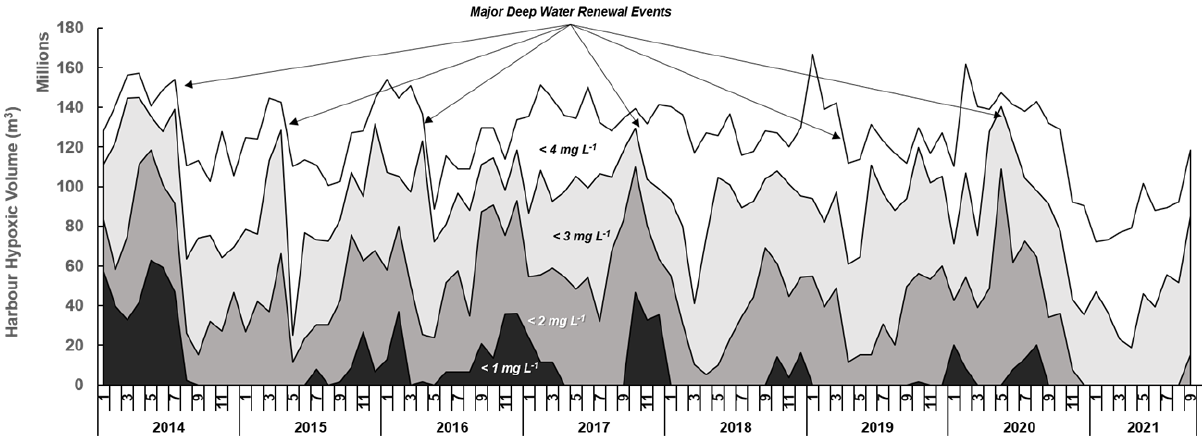
Figure 7. Estimated hypoxic volume present in the harbour from 2014 to 2021 based on our 1m resolution box model. Deep water renewal events are denoted by black